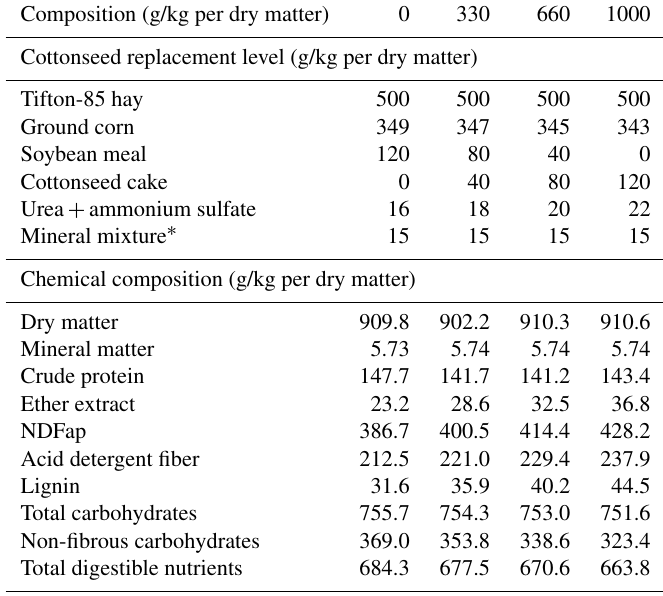
Table 1. Centesimal composition of ingredients and chemical composition of experimental diets. Composition (g/kg per dry